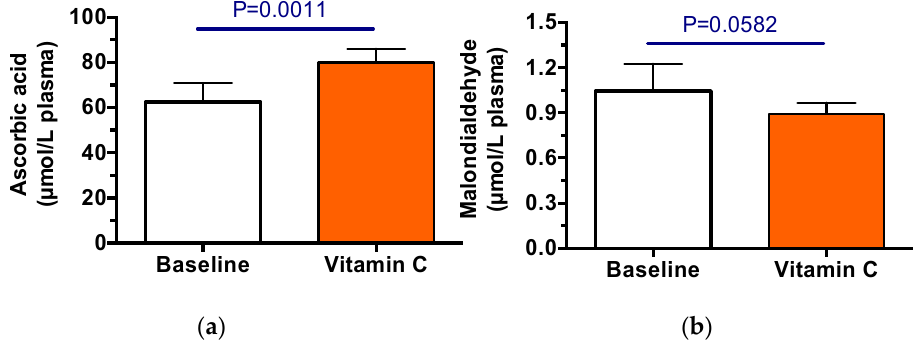
Figure 1. The efficacy of vitamin C supplementation in CF participants. Plasma concentrations of ascorbic acid ( a ) and malondialdehyde ( b ) during pharmacokinetic trials. Shown are the means ( ± SD, n = 6) of the average concentrations measured from plasma samples collected at 0, 3, 6, 9, 12, 24, 48, 72 h from each participant.